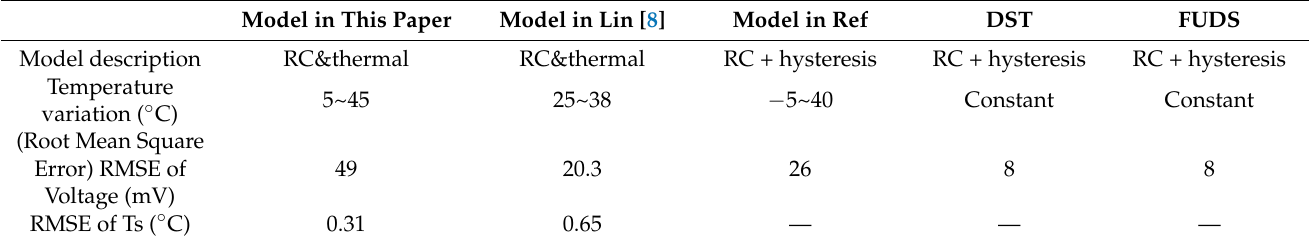
Table 5. Comparison of model performance